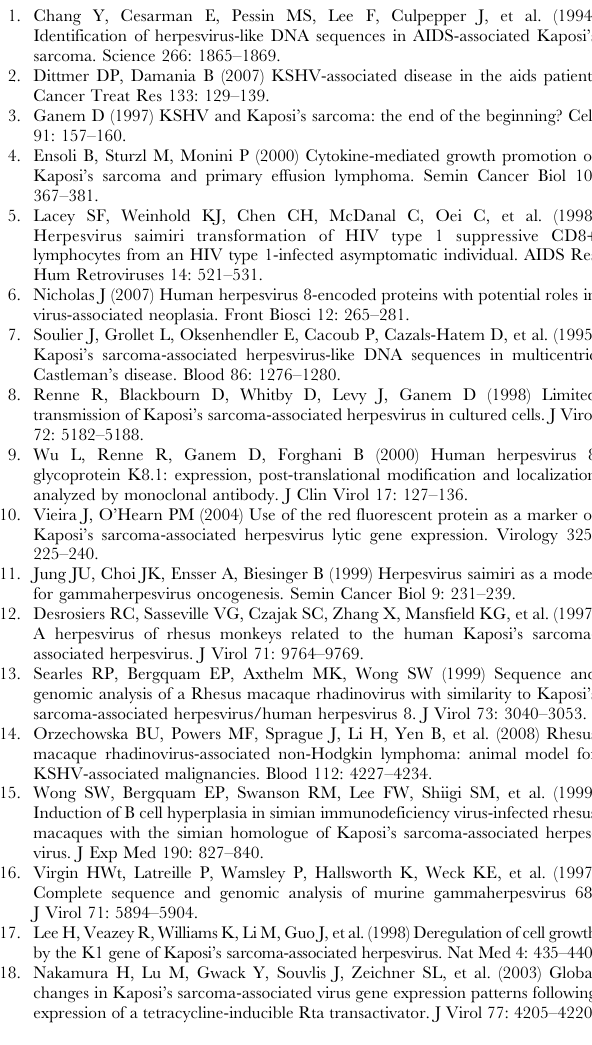
Figure S3 Immunohistochemistry of the KS-like skin lesion of Cj10-05 with an anti-K8.1 antibody. The inset in the left panel shows an enlarged view of the anti-K8.1 staining of the KS like lesion of Cj10-05. Irrelevant control tissue (right top panel) and KSHV-infected MCD (right bottom panel) were included as negative and positive controls, respectively, for anti-K8.1 staining. Figure S4 Immunophenotypic comparison of marmoset neo- plasm and human KS lesions. Marmoset (A, C, E, G, and I; insert: marmoset positive tissue control) and human tissues (B, D, F, H, and J) were compared immunophenotypically using an